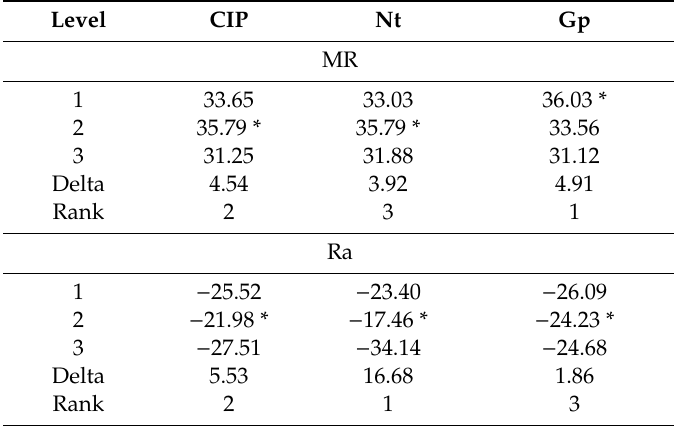
Table 5. S / N response of input process parameters.